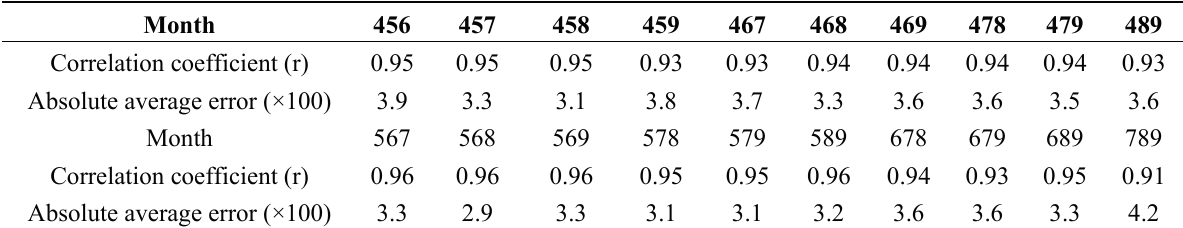
Table 3. Correlation coefficients (r) and the absolute average errors between the actual MODIS GSN and the predicted GSN for the three Landsat date combinations for the “clear and cloudy”